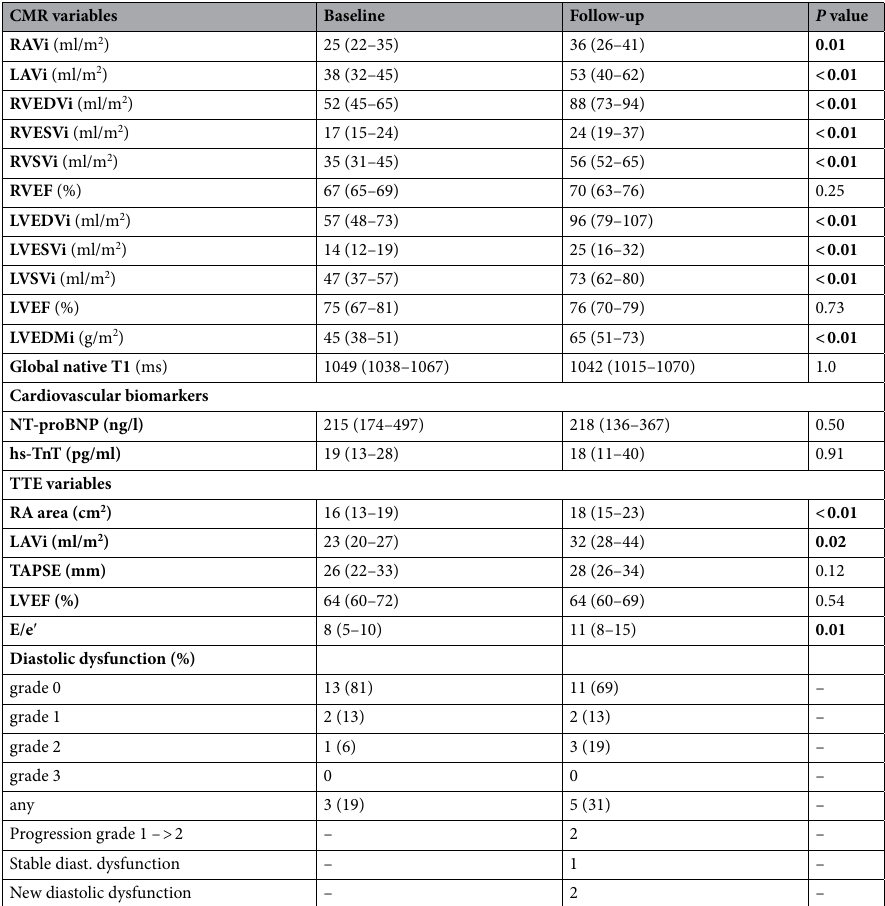
Table 2. CMR variables, TTE variables, and cardiovascular biomarkers of all patients with both, baseline and follow-up CMR (N = 16). Values are median (interquartile range) or n (%). LAVi = indexed left atrial volume; LVEDMi = indexed left ventricular myocardial mass; LVEDVi = indexed left ventricular end-diastolic volume; LVEF = left ventricular ejection fraction; LVESVi = indexed left ventricular end-systolic volume; LVSVi = indexed left ventricular stroke volume; hs-TnT = high-sensitive Troponin T; NT-proBNP = N-terminale pro-B-type brain natriuretic peptide; RA area = right atrial area; RAVi = indexed right atrial volume; RVEF = right ventricular ejection fraction; RVEDVi = indexed right ventricular end-diastolic volume; RVSVi = indexed right ventricular stroke volume; RVESVi = indexed right ventricular end-systolic volume; TAPSE = tricuspid annular plane systolic